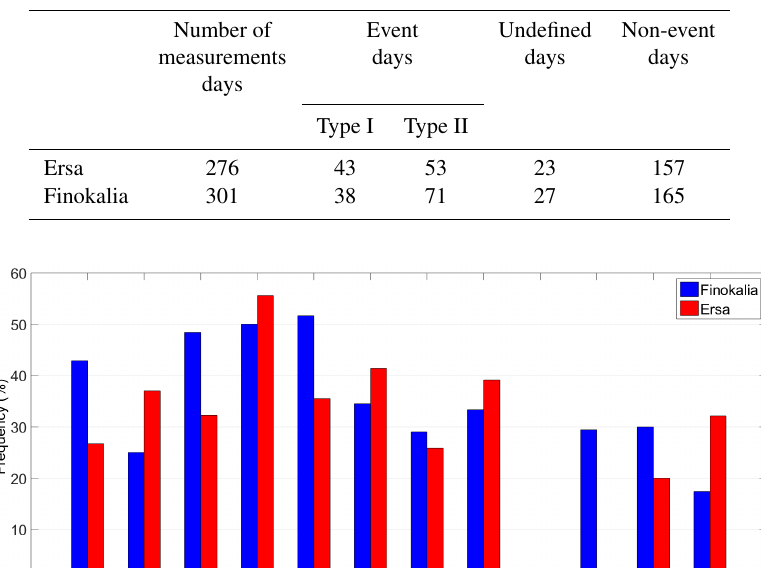
Table 1. Classification of measurement days in Ersa and Finokalia (after filtering bad data).